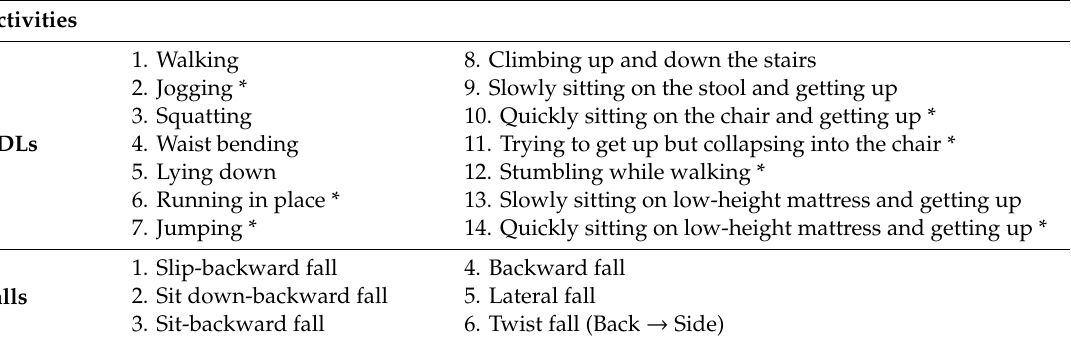
Table 1. List of